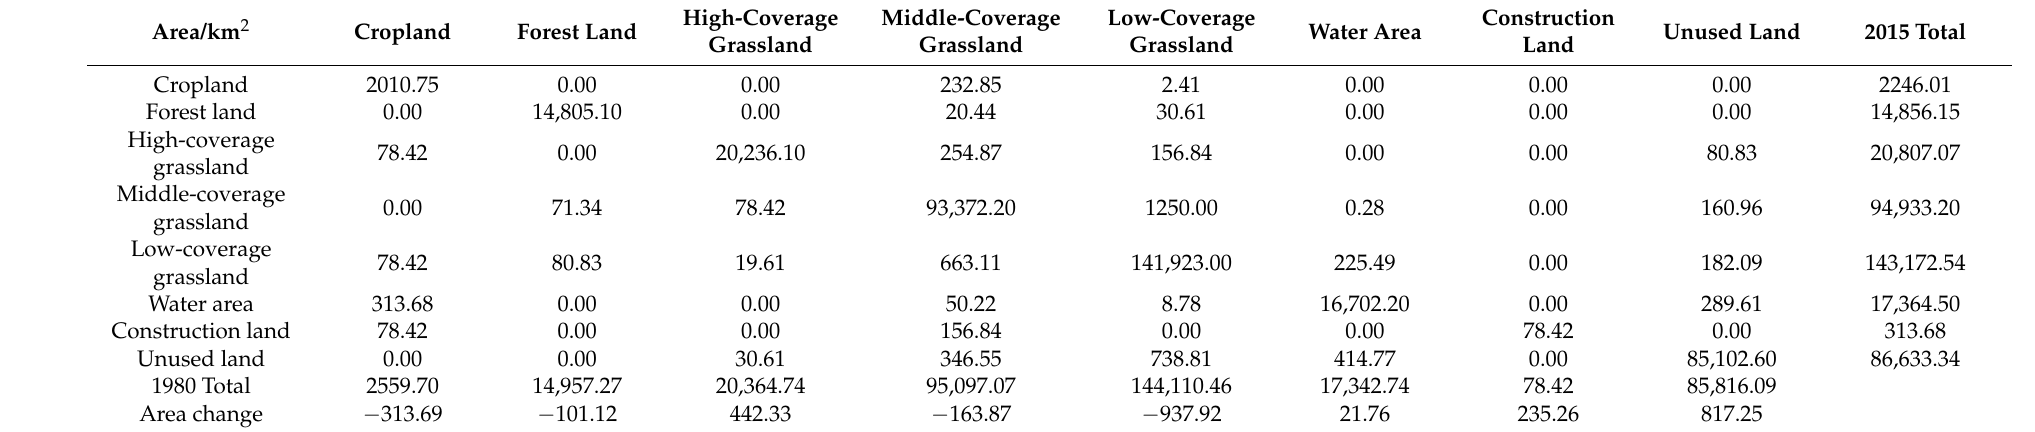
Table A1. Land use transfer matrix (km 2